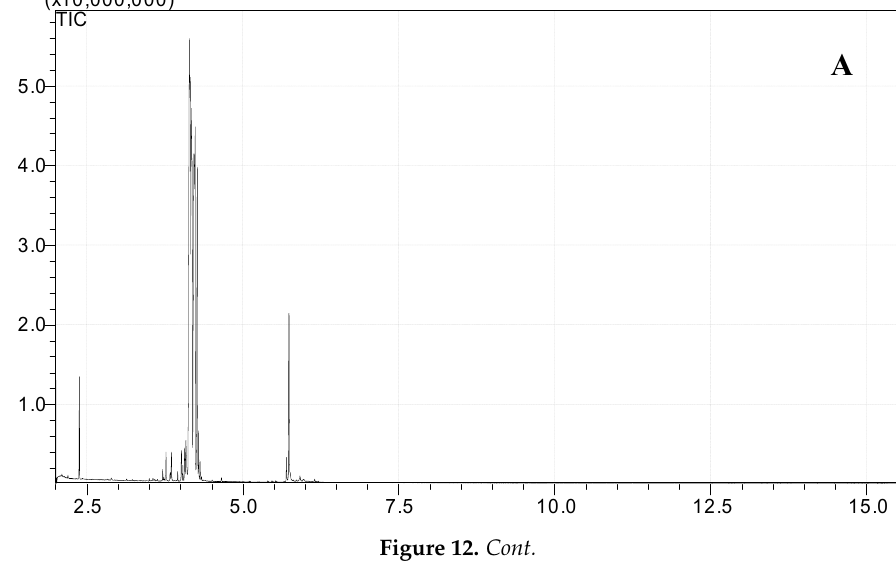
Figure 11. Mass spectrum of a blank sample (pyridine) at a retention time of 5.3 min.